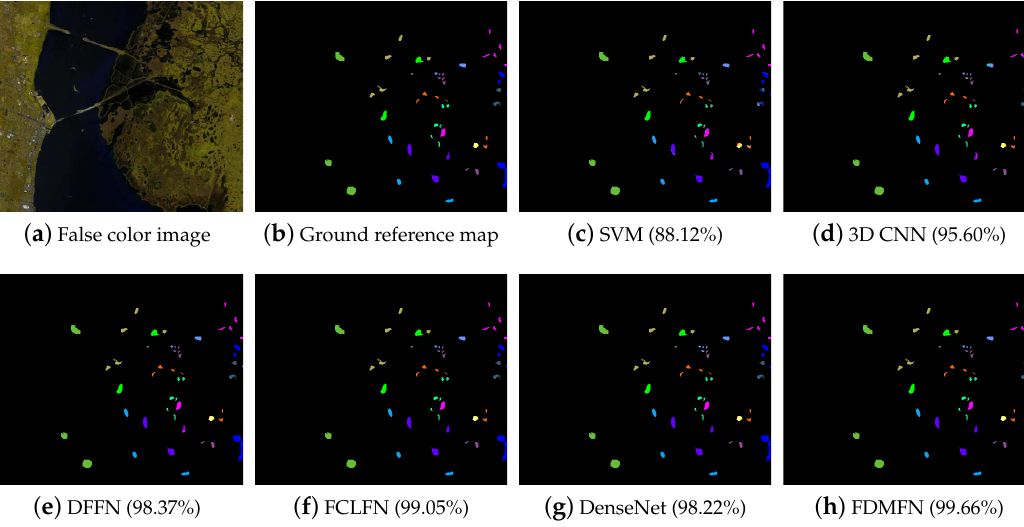
Figure 9. Classification maps and overall classification accuracies for the KSC